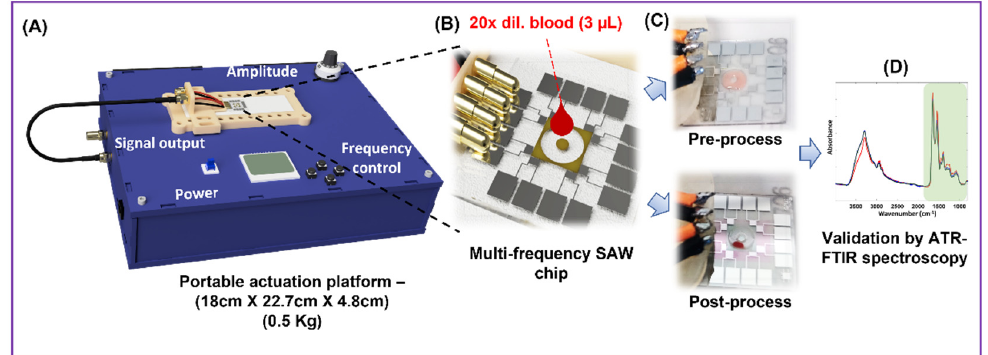
Figure 1. ( A ) Schematic diagram describing the process flow of the Haemoprocessor system for plasma separation. ( B ) The sample was first processed in the SU-8 process chamber. ( C ) The difference in the process chamber between pre-process and post-process. ( D ) Then, it was subject to IR spectroscopy for assessing the chemical composition of the obtained plasma.